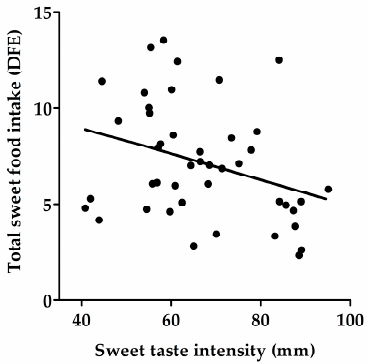
Figure 3. Relationship between sweet taste intensity of 1000 mM glucose and frequency of total sweet food intake. DFE: daily frequency equivalent. r = − 0.33, p = 0.03. n = 44.